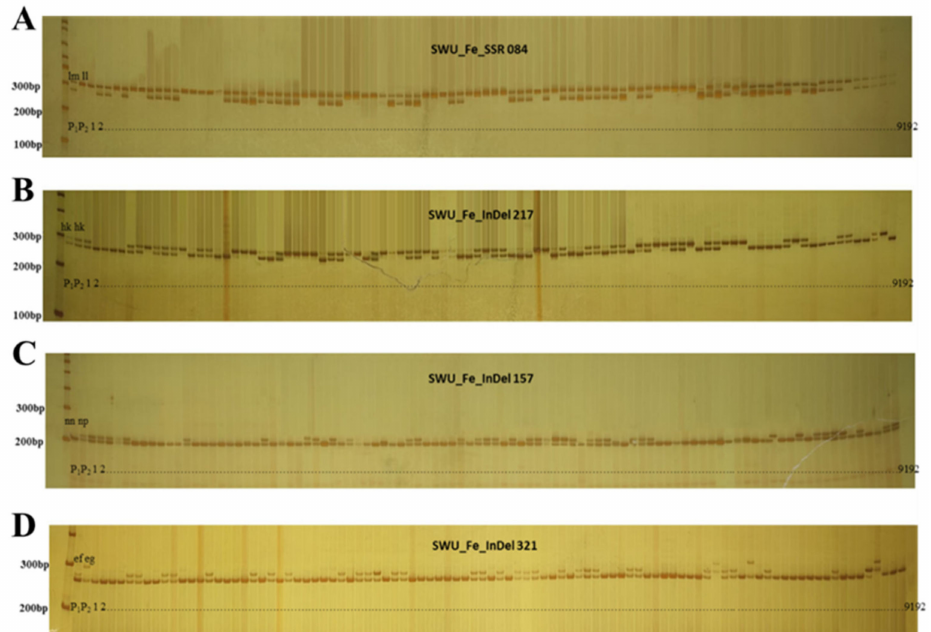
Figure 3. Electrophoregram of PCR products for F 1 individuals. P 1 : Youqiao2; P 2 : Ukraine daliqiao; 1–92: Individuals from the F 1 population. ( A ) segregation type lm × ll; ( B ) hk × hk; ( C ) nn × np; ( D ) ef × eg.